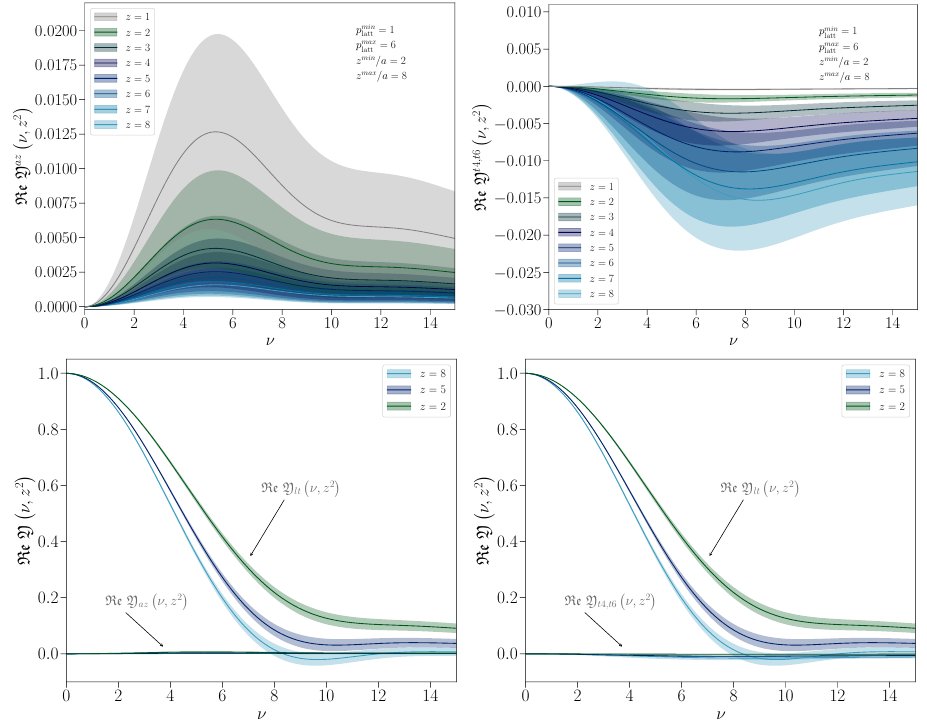
Figure 7 . (Upper left) Discretization and (Upper right) net higher-twist nuisance terms determined from the fit in figure 5 shown for z/a ∈ [1 , 8] . The lower two panels compare each nuisance effect (discretization at the left and higher-twist at the right) on an absolute scale with the parameterized leading-twist reduced pseudo-ITD Re Y the fit are presented in